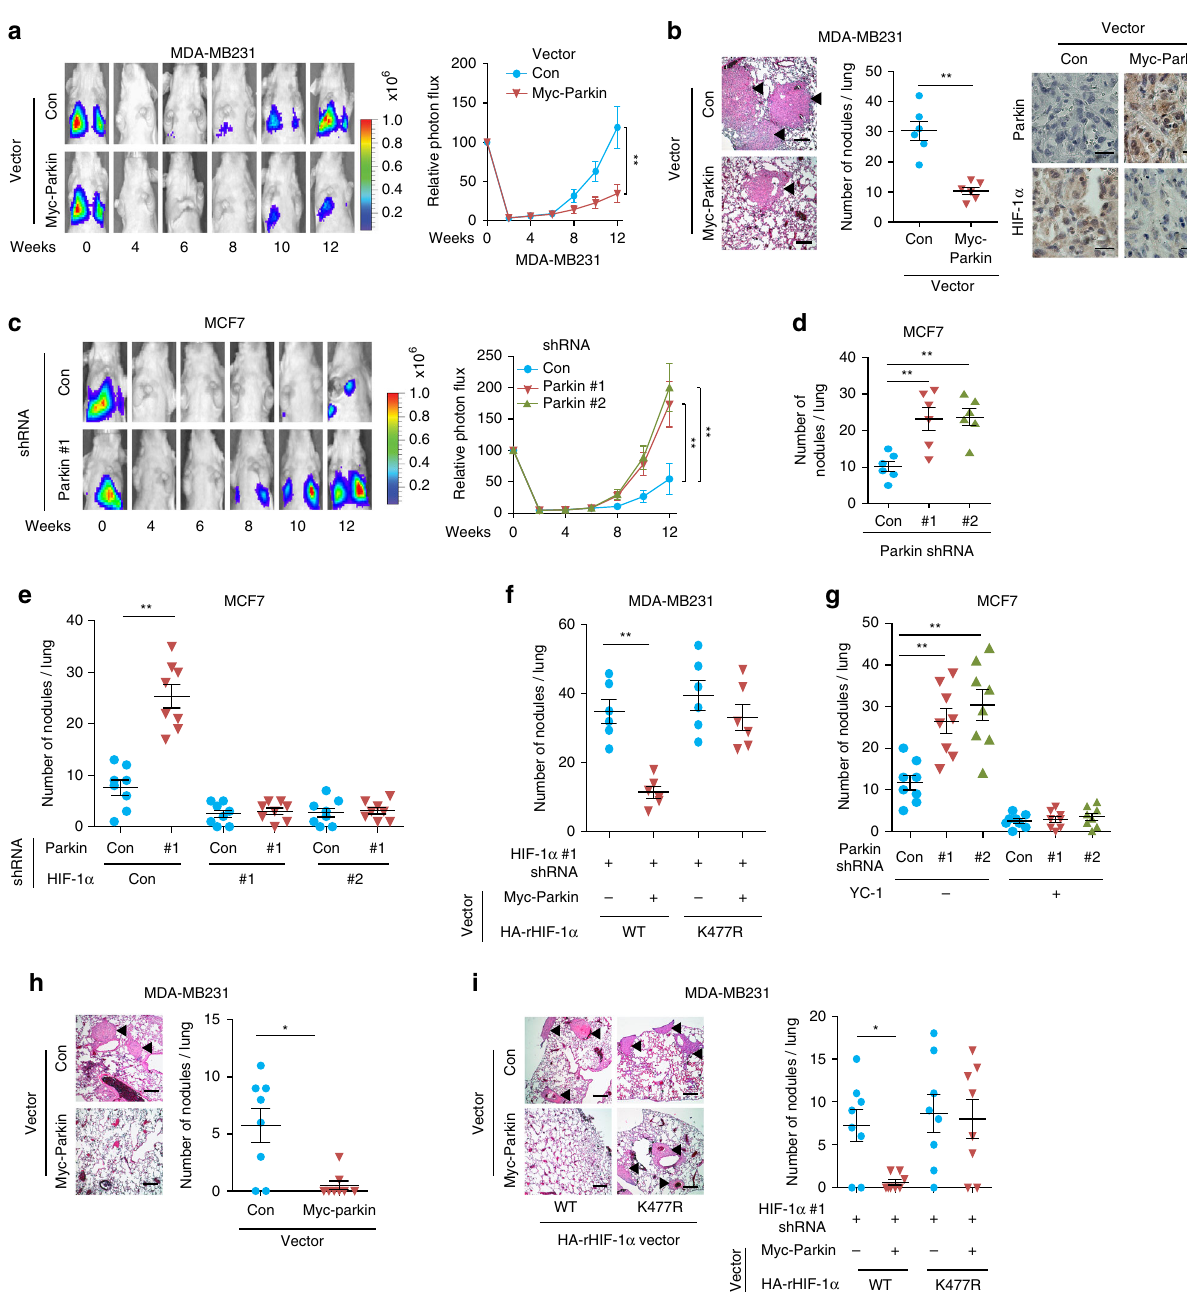
Fig. 7 Parkin inhibits lung metastasis of human breast cancer cells in vivo. a , b Myc-Parkin expression inhibited lung metastasis of breast cancer cells injected via the tail vein. MDA-MB231 cells with Myc-Parkin expression were transduced with lentiviral vectors expressing luciferase for tail vein injections. In a , left panel: representative bioluminescent images at indicated time points; right panel: normalized photon fl ux of lung metastases. In b , left panel: representative H&E-stained lung sections from mice at 12 weeks after injections. Arrows indicate metastatic nodules. Scale bar: 200 μ m. Middle panel: quanti fi cation of lung metastatic nodules. Right panel: IHC staining of Parkin and HIF-1 α in lung metastases. Scale bar: 20 μ m. c , d Knockdown of Parkin promoted lung metastasis of MCF7 cells injected via the tail vein. e HIF-1 α knockdown largely abolished the promoting effects of Parkin knockdown on lung metastasis of MCF7 cells after tail vein injections. Two different Parkin shRNA vectors were used and similar results were observed. f K477R HA-rHIF-1 α expression reduced the inhibitory effect of Myc-Parkin expression on lung metastasis of MDA-MB231 cells injected via the tail vein. Endogenous HIF-1 α in cells was replaced with WT or K477R HA-rHIF-1 α . g The HIF-1 α inhibitor YC-1 largely abolished the promoting effect of Parkin knockdown on lung metastasis. Mice were treated with YC-1 (30 mg kg − 1 per day; i.p.) for 5 days after the tail vein injection of MCF7 cells. h Myc-Parkin expression inhibited lung metastasis of MDA-MB231 cells implanted into mammary fat pads of mice. i K477R HA-rHIF-1 α expression reduced the inhibitory effect of Myc- Parkin on lung metastasis of MDA-MB231 cells implanted into mammary fat pads. In h , i , primary tumors were surgically removed when they reached a volume of ~200 mm 3 . Left panels in h , i : representative H&E-stained lung sections at 8 weeks after primary tumor removal. Right panels in h , i : quanti fi cation of lung metastatic nodules at 8 weeks after primary tumor removal. n = 6 mice per group in a – d , f ; n = 8 mice per group in e , g – i . The data present mean ± S.D. * P < 0.01; ** P < 0.001; ANOVA followed by two-tailed Student ’ s t tests in a , c , and two-tailed Student ’ s t tests in the remaining